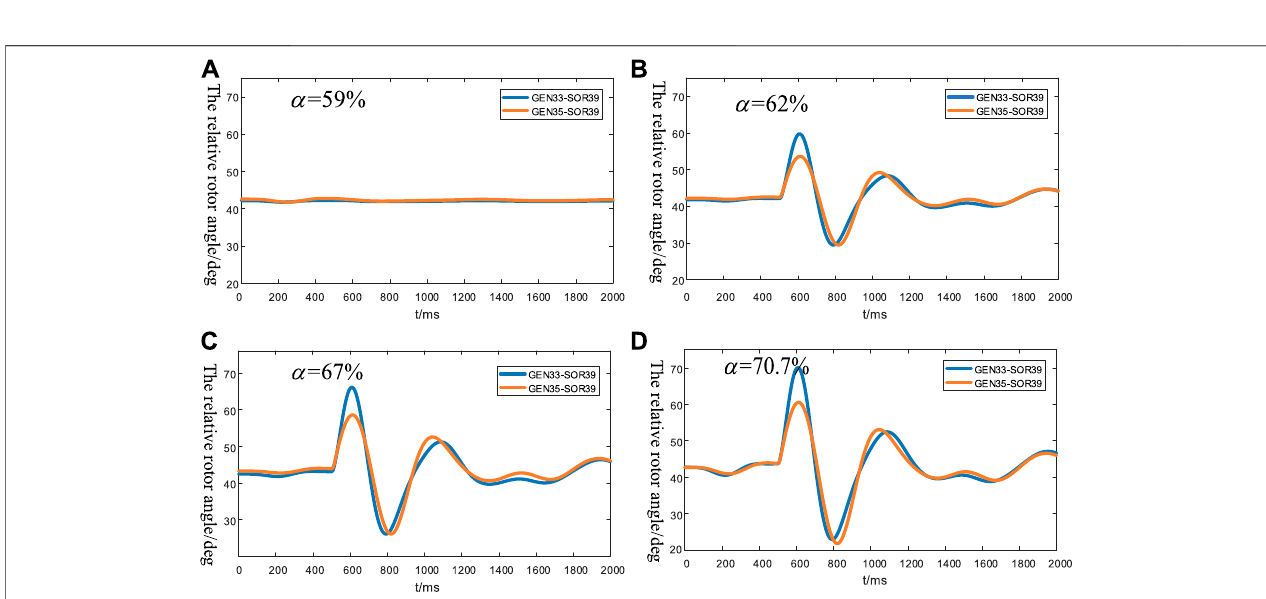
FIGURE11| TherelativeanglecurveofconstantACoperatingpoint (A) RelativeanglecurveofGEN33-SOR-39andGEN35-SOR39 at α (cid:2) 59% (B) Relativeangle curve of GEN33-SOR-39 and GEN35-SOR39 at α (cid:2) 62% (C) Relative angle curve of GEN33-SOR-39 and GEN35-SOR39 at α (cid:2) 67% (D) Relative angle curve of GEN33-SOR-39 and GEN35-SOR39 at α (cid:2) 70.7%.